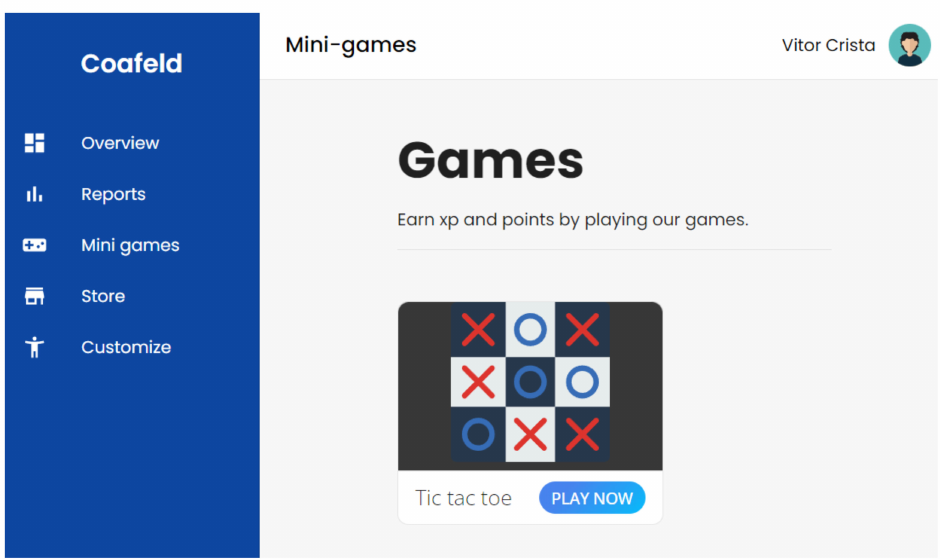
Figure 8. Cognitive games